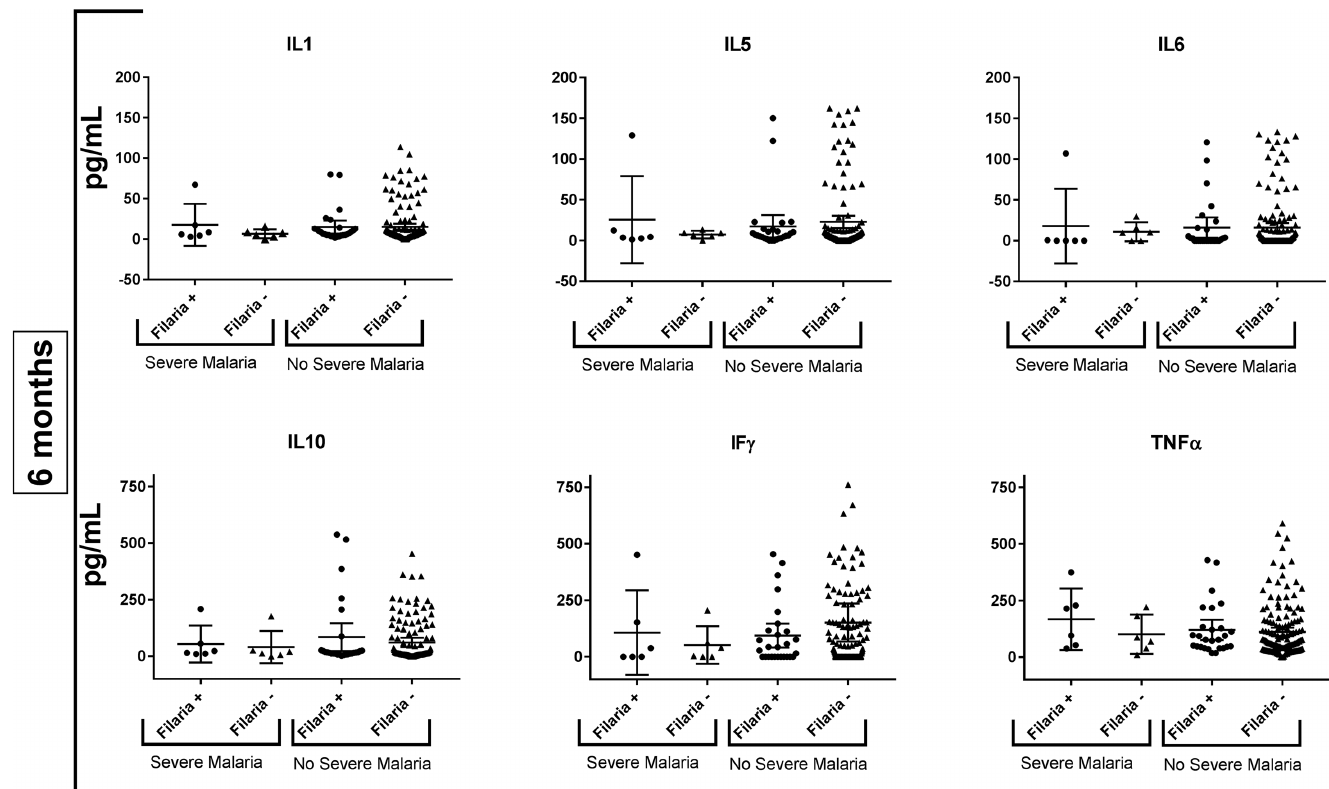
Fig 5. Cytokine profiles of children in the study at 6 months by filarial serostatus, stratified by whether they experienced (“Severe Malaria”) or did not experience (“No Severe Malaria”) severe malaria between 6 and 12 months of age. No significant differences in cytokine levels were detected for children who did versus did not develop severe